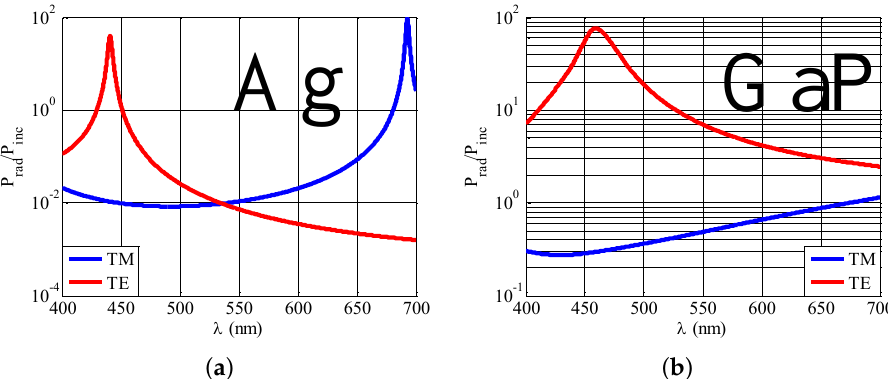
Figure 9. Frequency response for both excitations (TE and TM waves) of: ( a ) the Ag cladding of Figure 4, TM-optimized at λ = 693 nm, and ( b ) the GaP cladding of Figure 5, TE-optimized at λ = 460